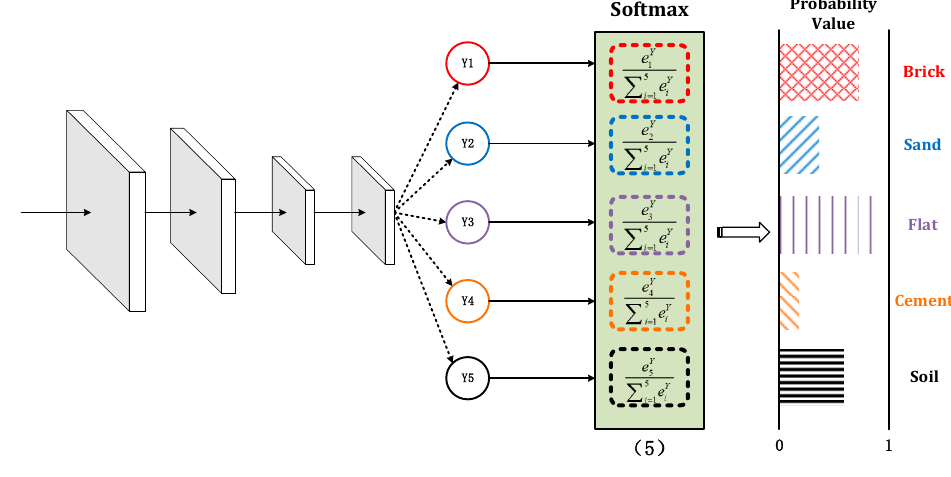
Figure 7. Softmax function output.